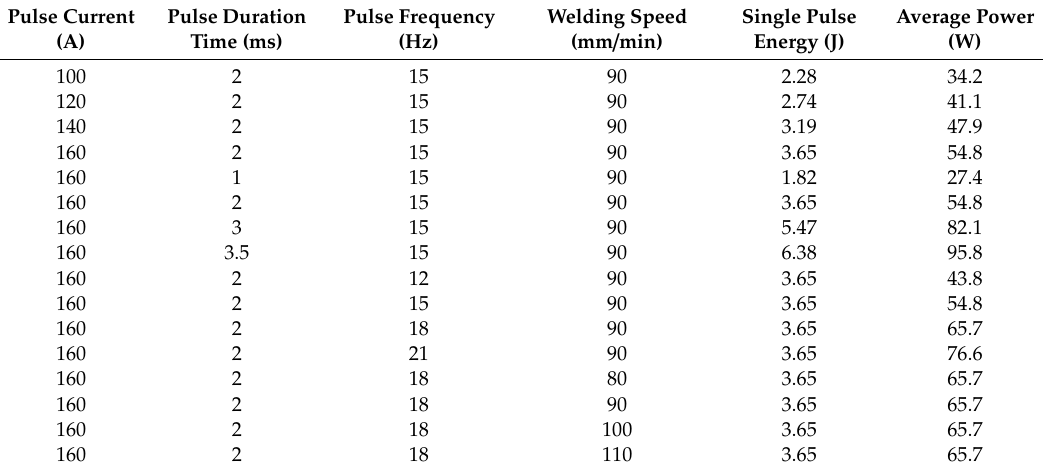
Figure 1. HGL-LCY300 type Nd:YAG laser welding system. Table 2. The laser process parameters used in the tests.